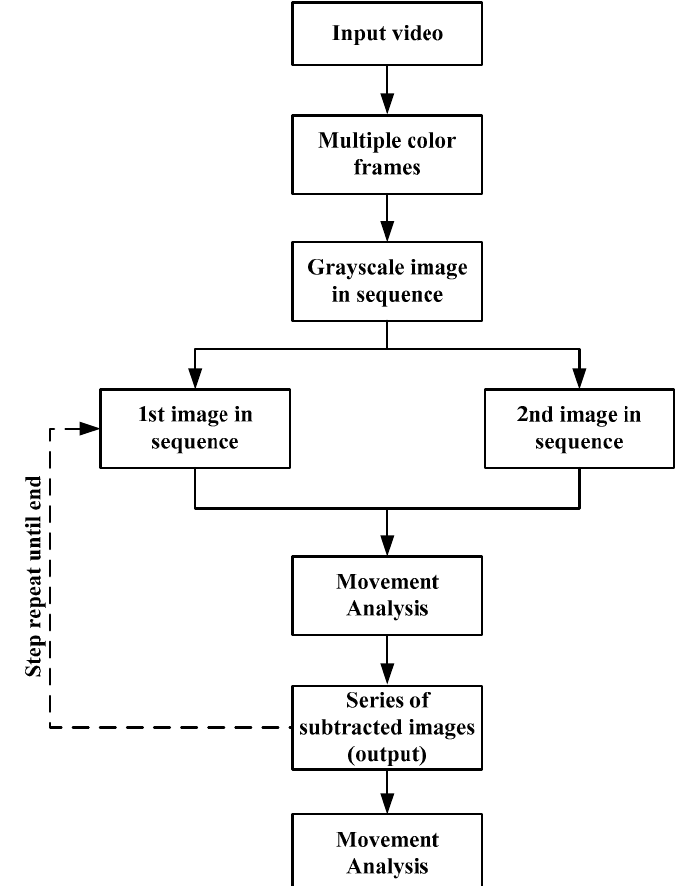
Figure 2. Video recorder’s positioning and view in the consultation room.